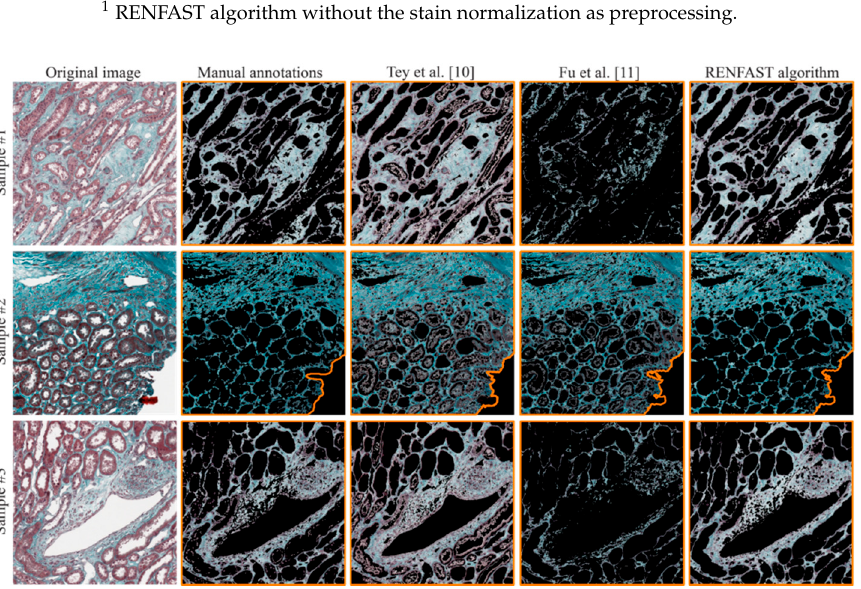
Figure 8. Visual performance comparison between previously published papers for fibrosis detection and the RENFAST algorithm. The fibrosis mask is superimposed on the original image, while the tissue contour is highlighted in orange.